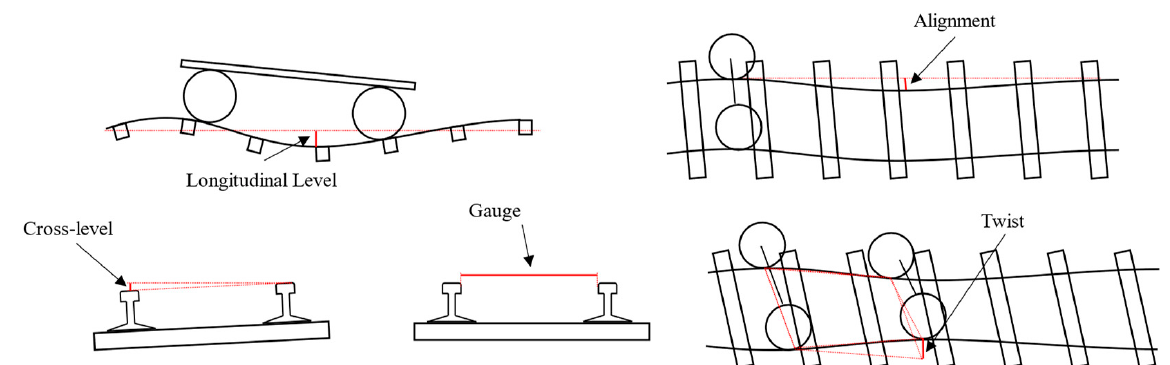
Figure 1. Definition of track geometry parameters.